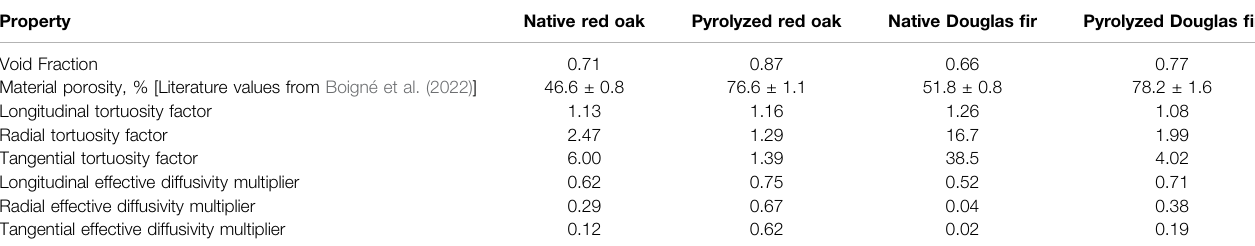
TABLE 1 | Calculated void fraction, directional tortuosity factors of the void phase, and directional effective diffusivity multipliers [see Eq. 9 ] of each species before and after pyrolysis.